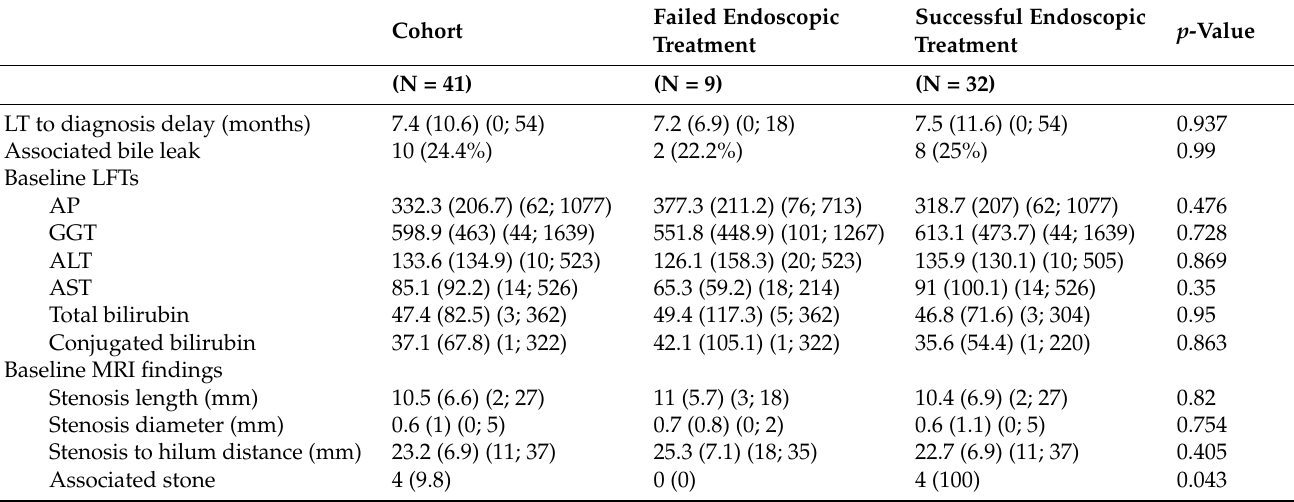
Table 2. Patients baseline LFTs and MRI findings.